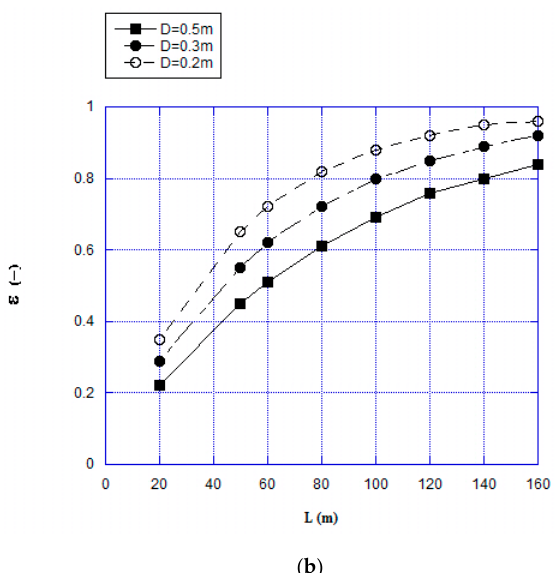
Figure 9. ( a ). E ffi ciency of the EAHX during summer season as a function of the tube length for three Figure 9. ( a ). Efficiency of the EAHX during summer season as a function of the tube length di ff erent inner tube diameters. ( b ). E ffi ciency of the EAHX during summer season as a function of the for three different inner tube diameters. ( b ). Efficiency of the EAHX during summer season as a tube length for three di ff erent inner tube function of the tube length for three different inner tube diameters.